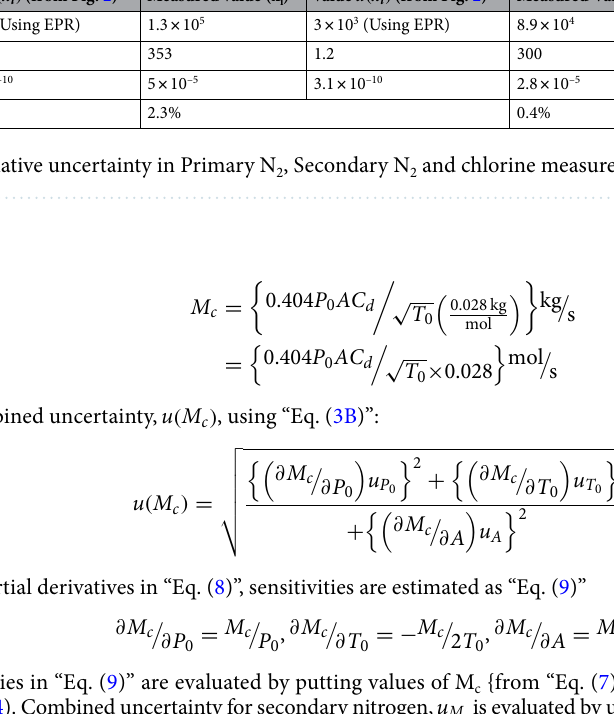
Using partial derivatives in “Eq. (8)”, sensitivities are estimated as “Eq. (9)”